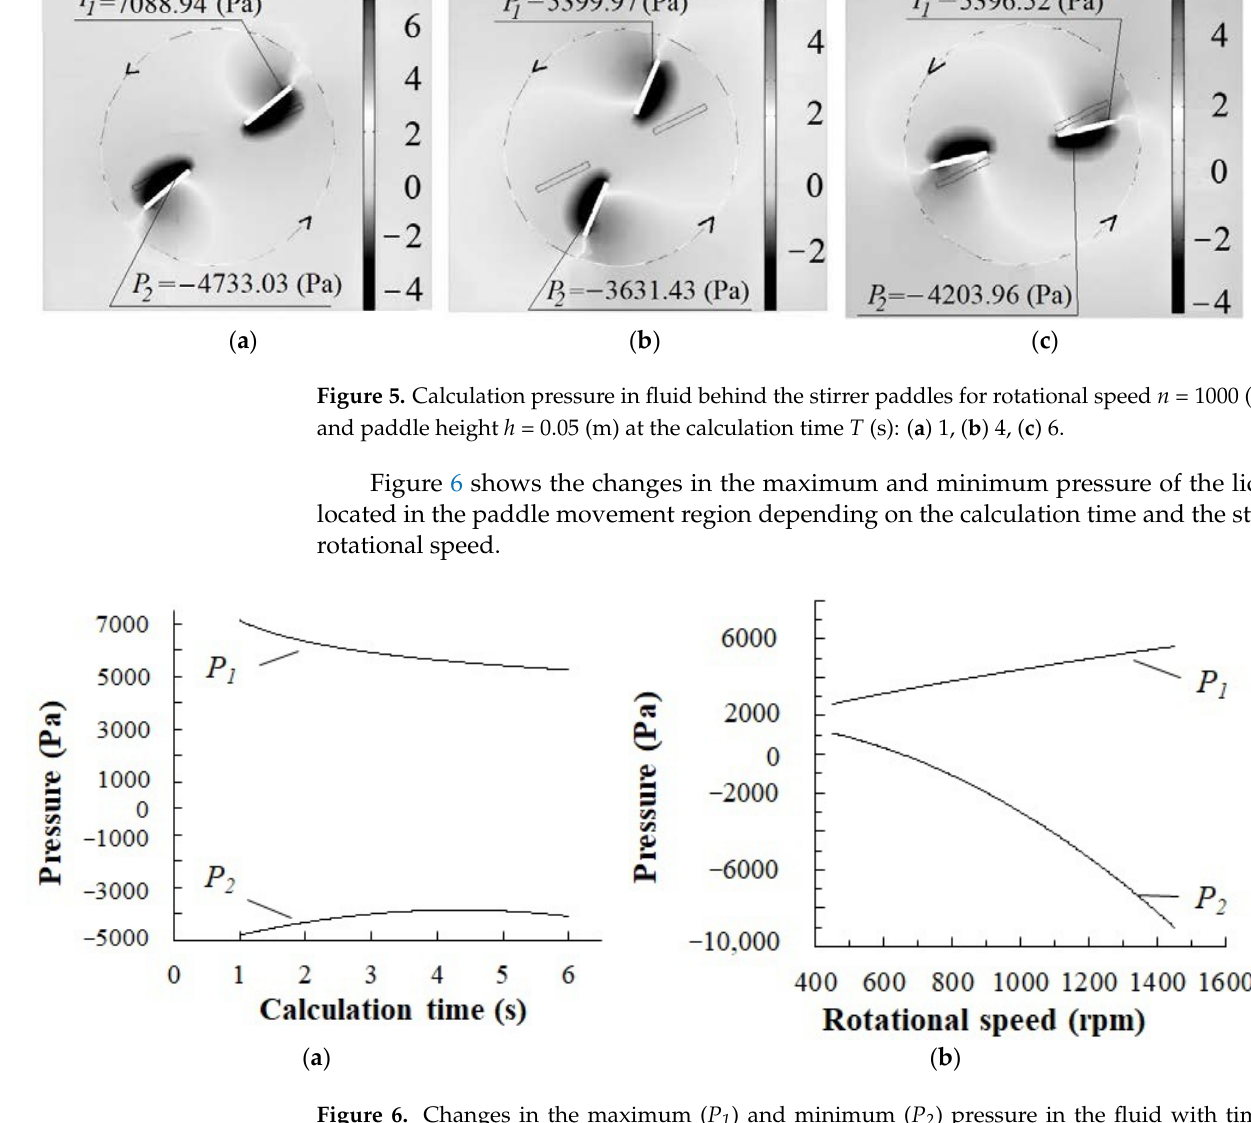
Figure 4. View of the gas–liquid medium in the apparatus without partitions ( a – c ) and with two partitions ( d – f ) with a change in the rotational speed at H L / D = 1.2, D = 0.28 (m), d s = 0.064 (m), b = 0.025 (m), h = 0.3 (m) (I), and h = 0.05 (m) (II): ( a , d ) 600 (rpm); ( b , e ) 900 (rpm); ( c , f ) 1200 (rpm).